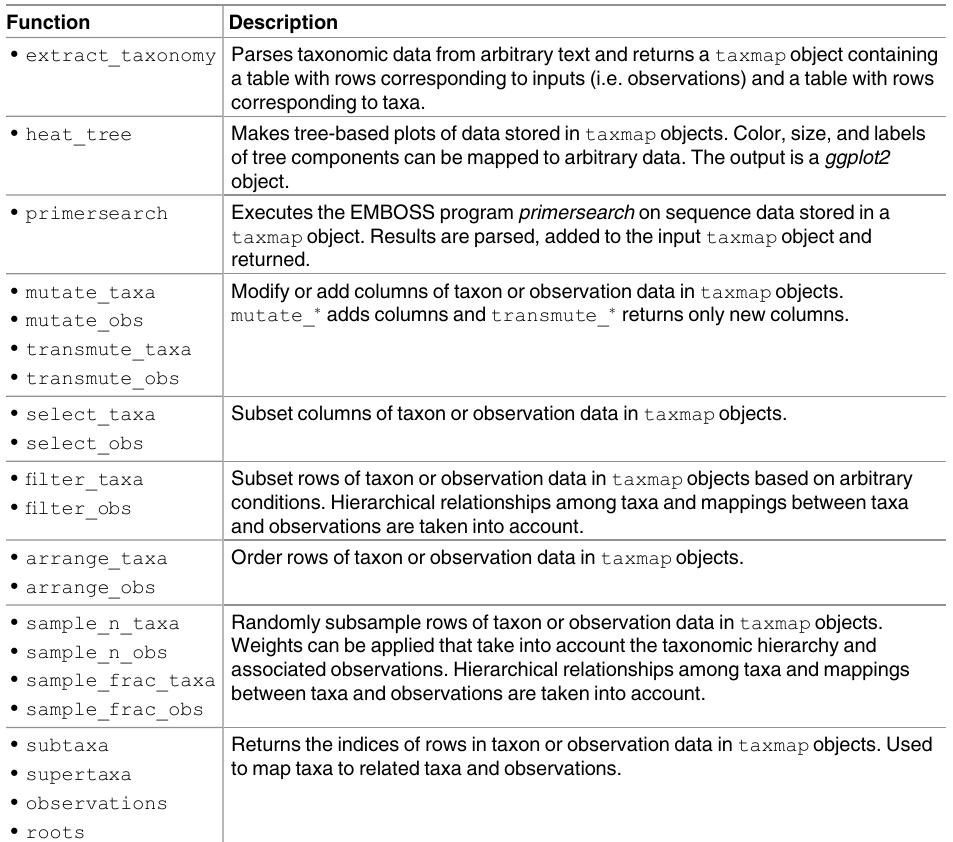
Table 1. Primary functions found in metacoder